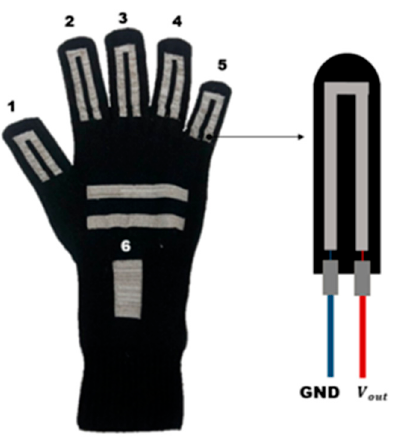
Figure 1. The strain sensor placements of the knitted sensing glove [24].